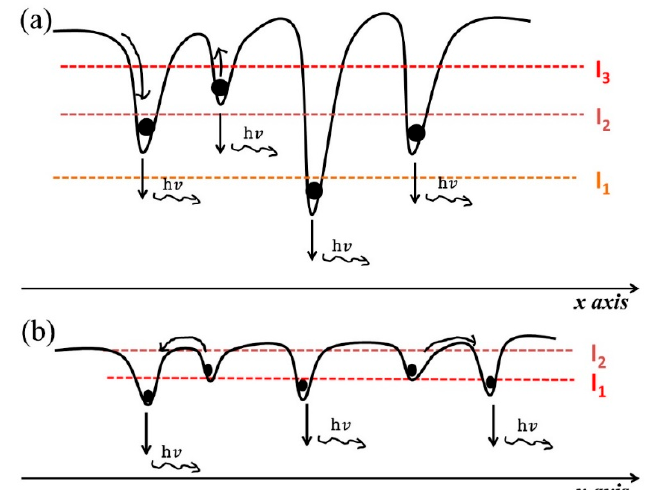
Figure 10. Transport mechanism of the excitons in quantum wells at low temperatures for ( a ) green LED and ( b) blue